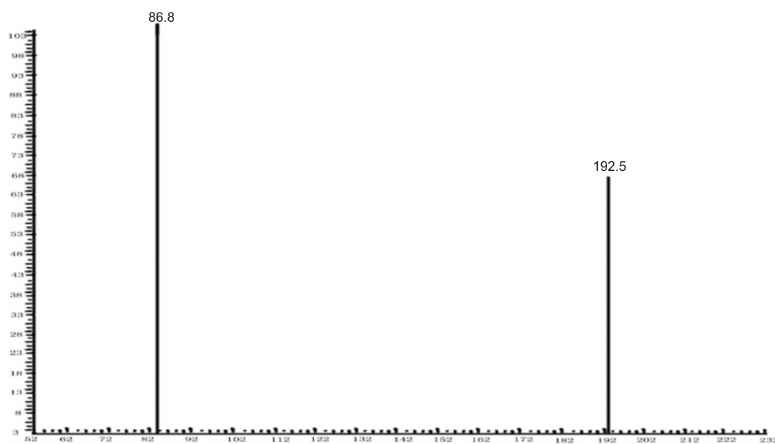
Fig. 2. Spectrum of glutamate acid with ion trap LC